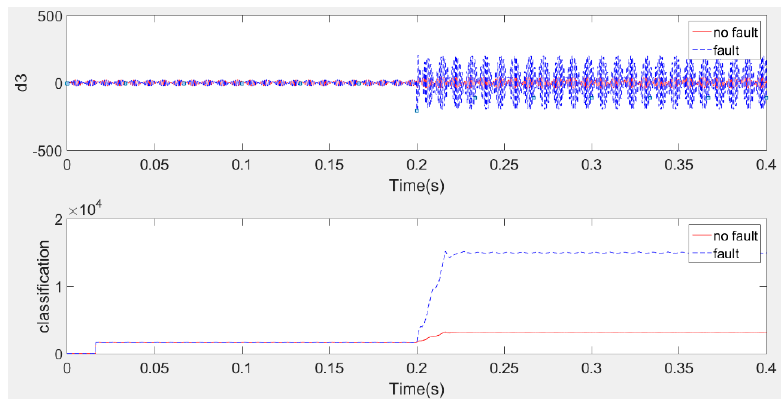
Figure 10. D3 coefficient and new index at haar MW.